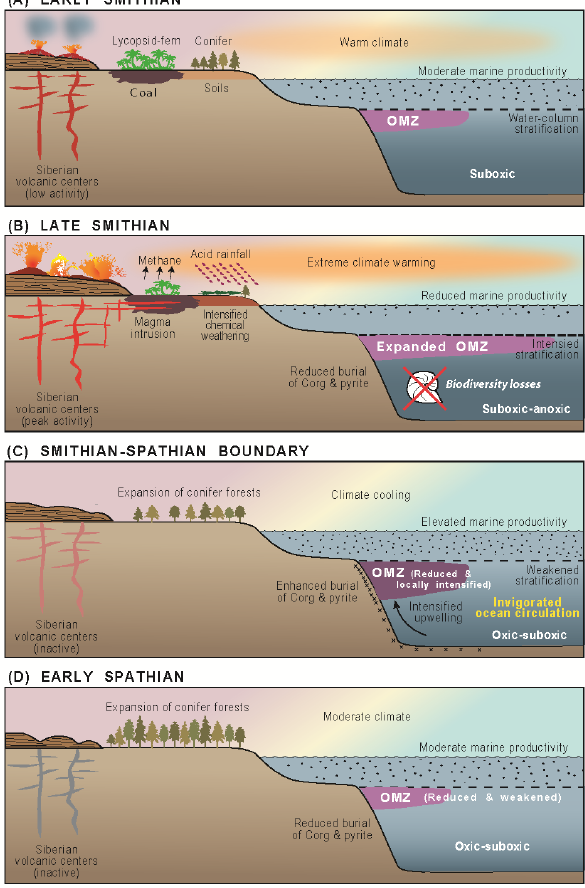
Figure 6. Evolution of terrestrial and marine environments during the late Early Triassic: (a) early Smithian, (b) late Smithian ther- mal maximum (LSTM), (c) Smithian–Spathian boundary, and (d) early Spathian. This model integrates changes in subaerial weath- ering rates and oceanic productivity and redox conditions docu- mented in this study with data regarding paleoclimate variation, ter- restrial floral assemblages, and marine biodiversity patterns from other sources (cited in text). We infer that the modeled environmen- tal changes were ultimately due to variation in the eruption rate of the Siberian Traps, although this has not been proven to date. See text for further